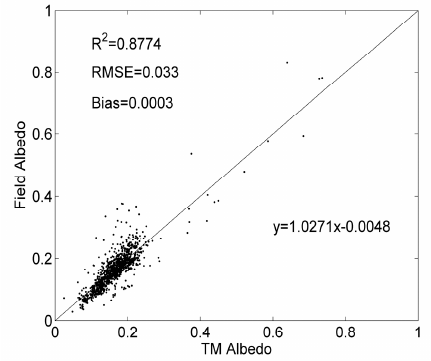
Figure 1. Field data comparison with Landsat Thematic Mapper (TM) data, which is the average of 3 × 3 pixels. The fitting function is then used for TM albedo data calibration.